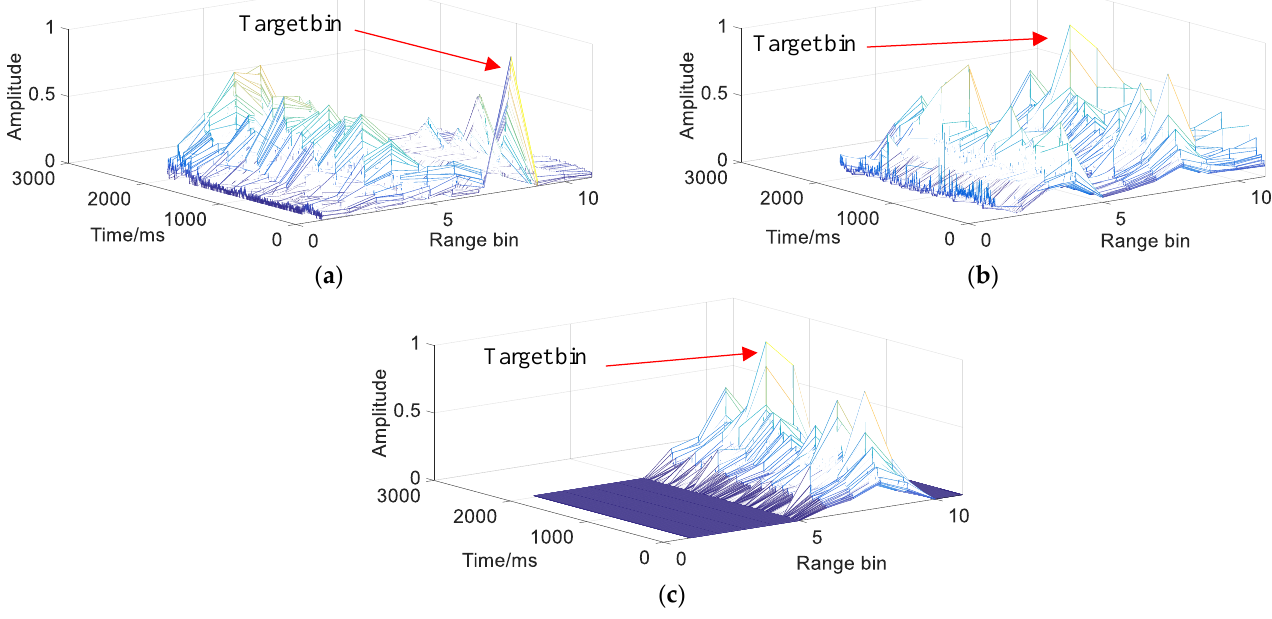
Figure 7. Comparison results of whitening filter on IPIX-#1. ( a ) Raw data(5.70dB). ( b ) Traditional whitening(4.08dB). ( c ) Selective whitening(12.32dB).